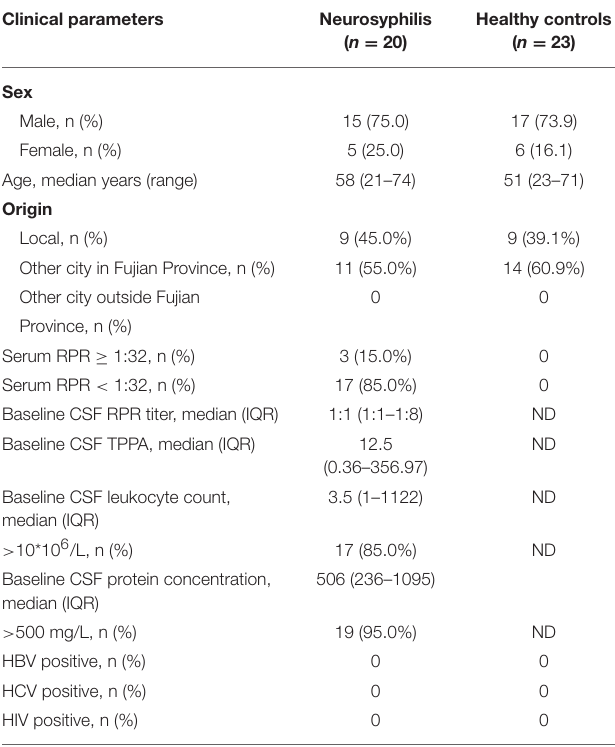
TABLE 1 | Demographic data and clinical data of the patients with neurosyphilis and healthy controls in southern China. Clinical